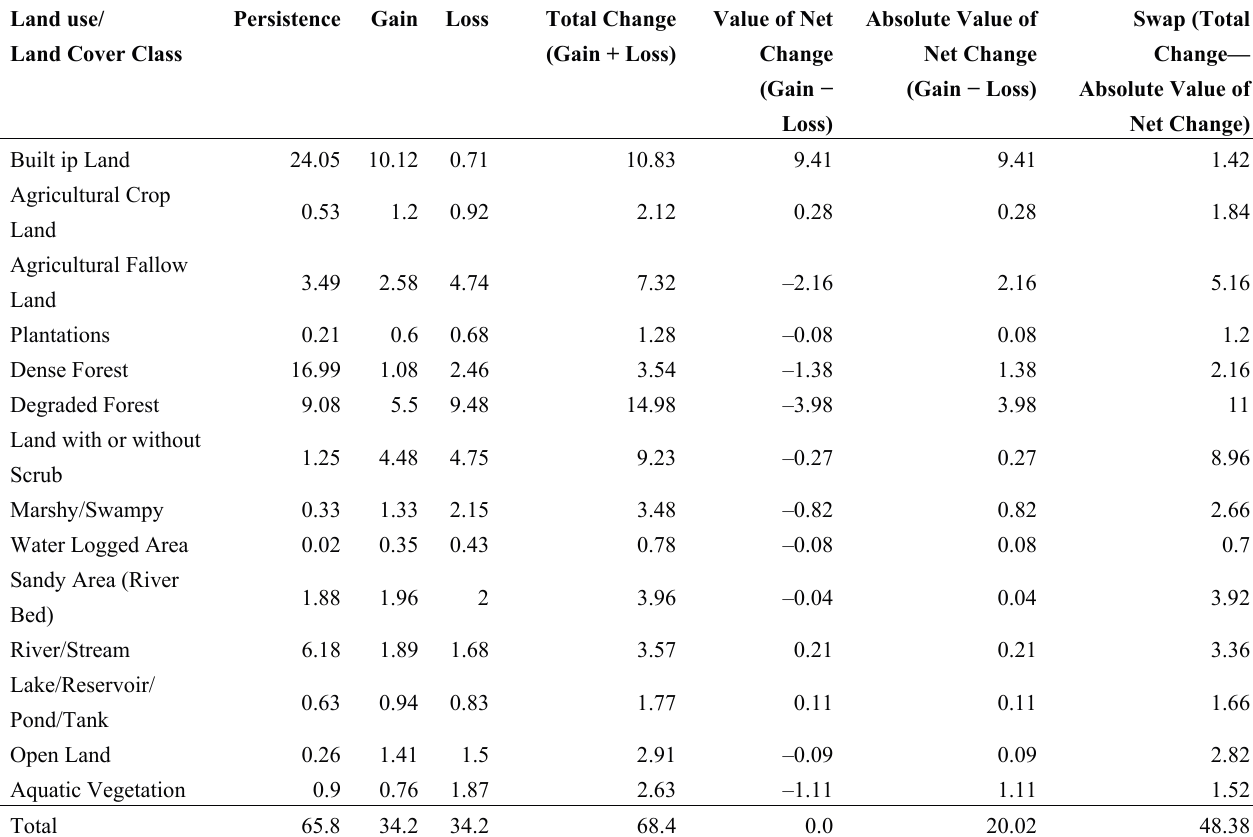
Table 10. Statistics of landscape persistence and components (gains and losses) of change in terms of percent of study area in the time periods